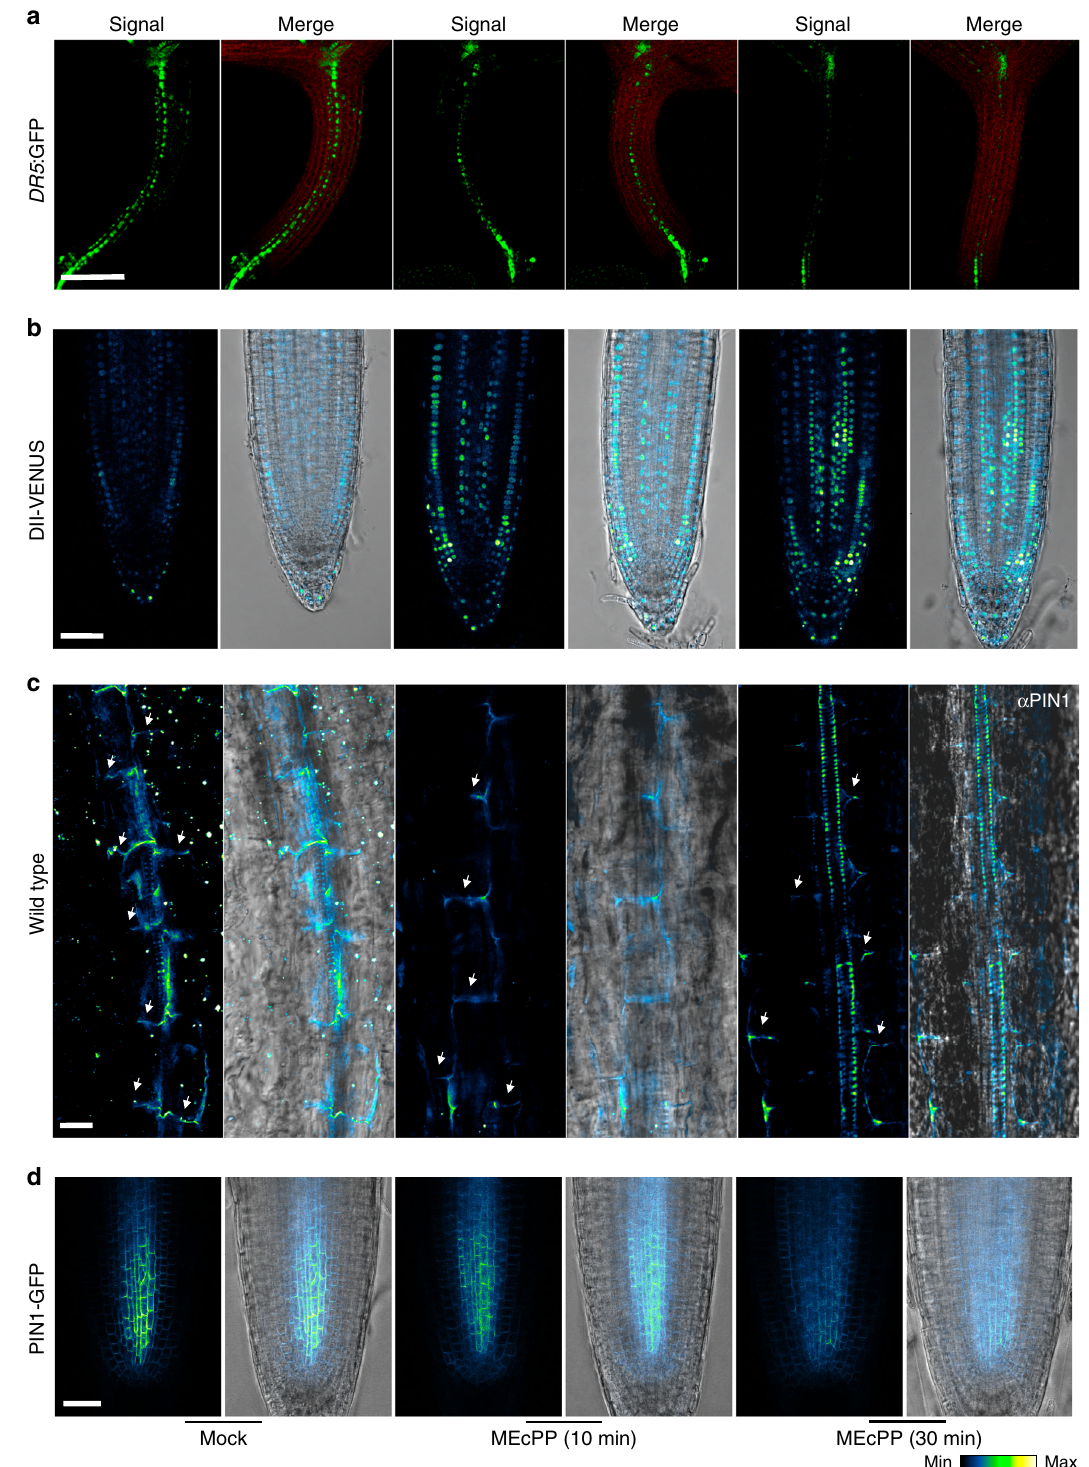
Fig. 4 MEcPP reduces DR5 :GFP and PIN1 abundance. a , b Representative images of a DR5 :GFP and b DII-VENUS signal intensities in hypocotyls and roots of 7-day-old seedlings, before and at intervals after MEcPP application, respectively. DR5 :GFP (green), chloroplast fl uorescence (red), DII-VENUS (blue) from 10 independent experiments. c , d Representative images of c PIN1-imuno and d PIN1-GFP signal intensities in hypocotyls and roots of 7-day-old seedlings, before and at intervals after MEcPP application, respectively. c PIN1 immunolocalization using α PIN1 antibody (left) and merged image with bright fi eld (right), from three independent experiments and n ≥ 8 biological replicates each. The color-coded bar displays the PIN1 fl uorescence intensity. Scale bars:100 μ m ( a ) and 20 μ m ( b ‒ d